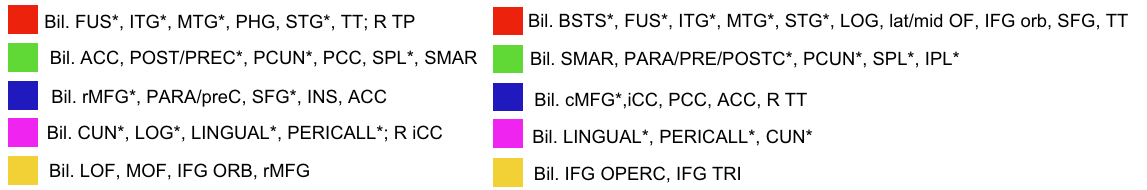
Fig. 8 Hubs and communities: surface area. a SA hubs identi fi ed based on ef fi ciency, betweenness centrality and degree. Regions marked with a * are common hubs for both VH and noVH patients. b Communities identi fi ed for each group. Legend: red = 1st community, green = 2nd, blue = 3rd, pink = 4th, yellow = 5th. The regions identi fi ed for that same community also in the cortical thickness analysis are marked with a *. BSTS banks superior temporal sulcus, IPL inferior parietal lobule, SPL superior parietal lobule, LOG lat. occipital gyrus, MTG middle temporal gyrus, STG superior temporal gyrus, ITG inferior temporal gyrus, cMFG caudal middle frontal gyrus, PHG parahippocampal gyrus, paraC paracentral gyrus, preC precentral gyrus, postC postcentral gyrus, IFG inferior frontal gyrus, SFG superior frontal gyrus; SMAR supramarginal gyrus, FP frontoparietal thickness, TT temporal transverse, FUS fusiform gyrus, CUN